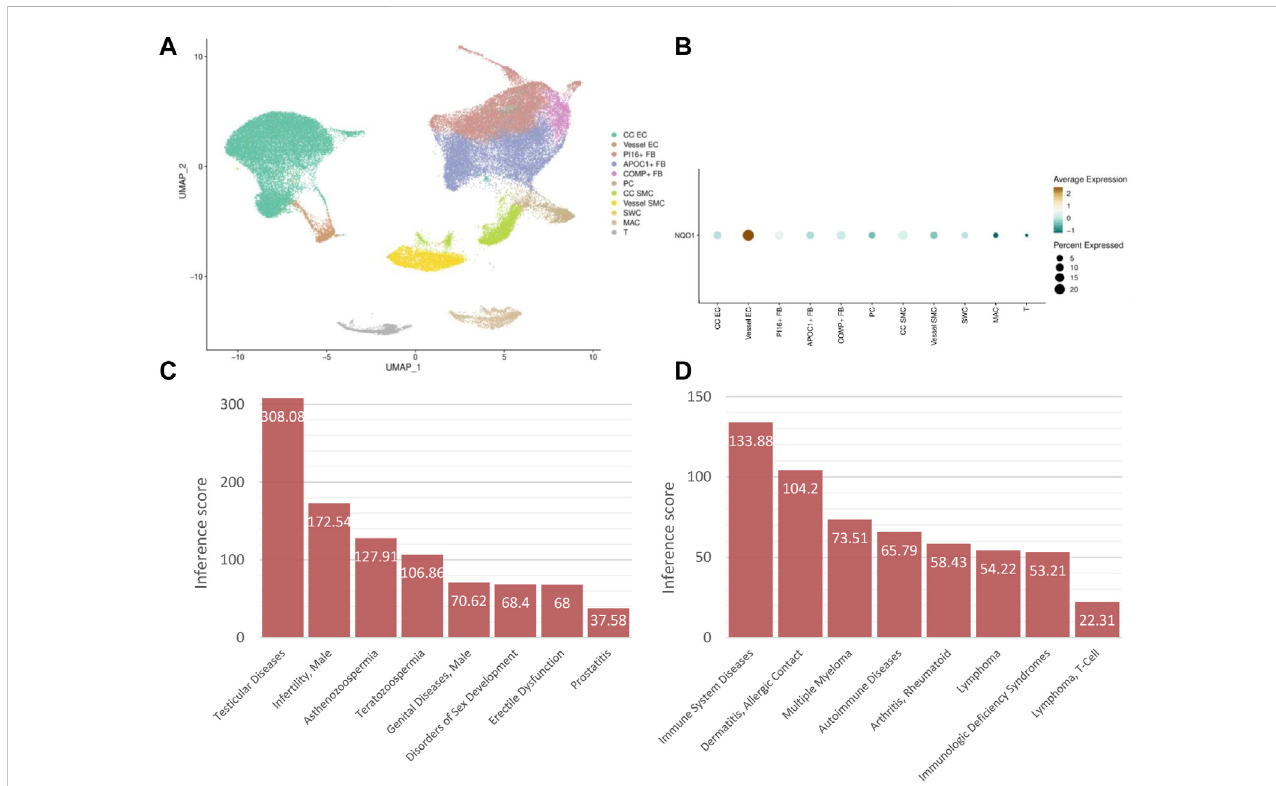
FIGURE 8 Subpopulation distribution and disease association of hub CPRGs (A) UMAP visualization of subpopulations clustering in human corpus cavernosum. (B) Expression distribution of NQO1 in ED patients grouped by cell types. (C) The association between NQO1 and male urogenital diseases. (D) The association between NQO1 and immune system diseases. CP, chronic prostatitis; CPPS, chronic pelvic pain syndrome; CPRGs, CP/CPPS-related genes; ED, erectile